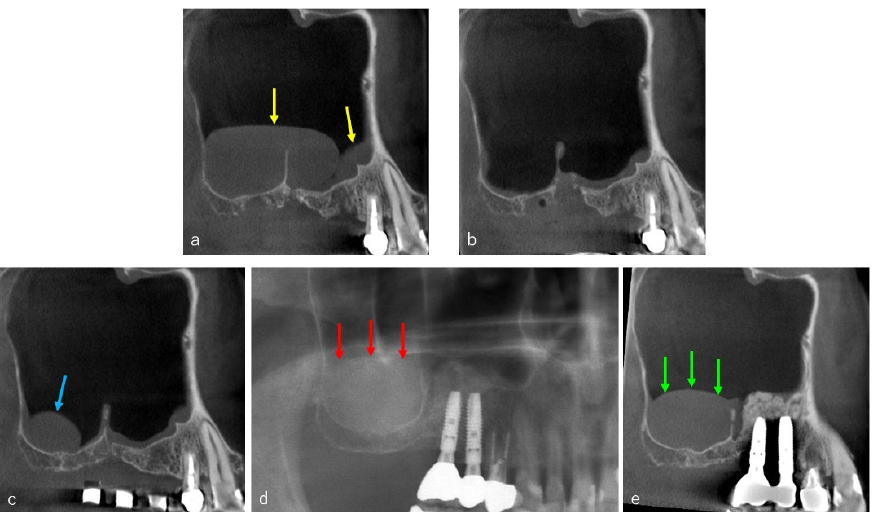
Figure 9. Case: 60 years old male. Two APs were observed, and the posterior AP existed across the septum ( a ), yellow arrows). They were removed, and the curettages of the extraction sockets were performed simultaneously ( b ). Three months after the removal, a relapse of AP had been occurred at the posterior area of septum (( c ), blue arrow). Eight months after the removal, the sinus floor augmentation was performed only at the medial area of septum, and two implants were placed at the augmented area. Two point five years after the removal of APs, a panoramic radiograph (( d ), red arrows) and a sagittal section CT image (( e ), green arrow) showed the increased AP at the posterior area of septum.